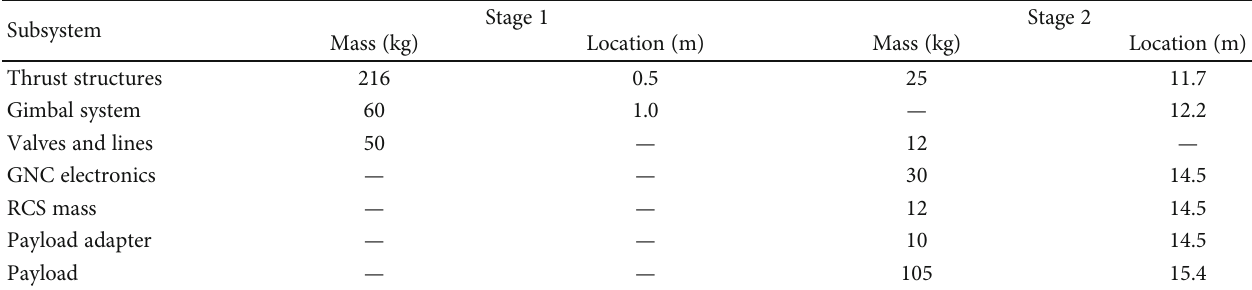
Table 7: Additional masses of the launch vehicle model.